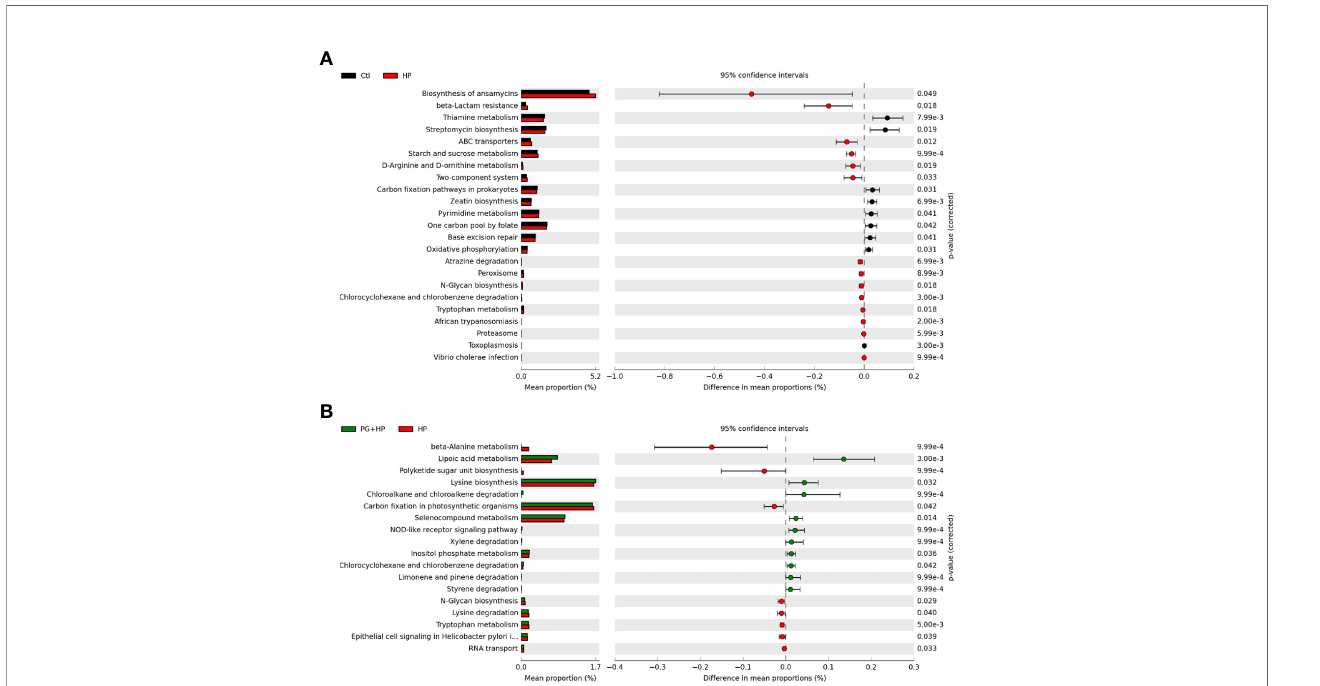
FIGURE 7 | Putative functions of microbiota community. The microbial functionality pro fi les altered by P. goldsteinii MTS01 and H. pylori were analyzed using PICRUSt2 to generate KEGG pathway. Functional features showed the comparison between (A) control and H. pylori , and (B) H. pylori and P. goldsteinii MTS01+ H. pylori .